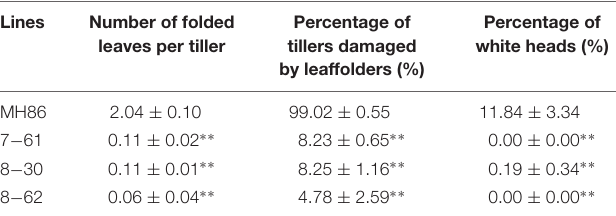
TABLE 1 | Resistance of transgenic homozygous lines against rice leaf folder and stem borers in the field under artificial infestation combined with natural infestation in